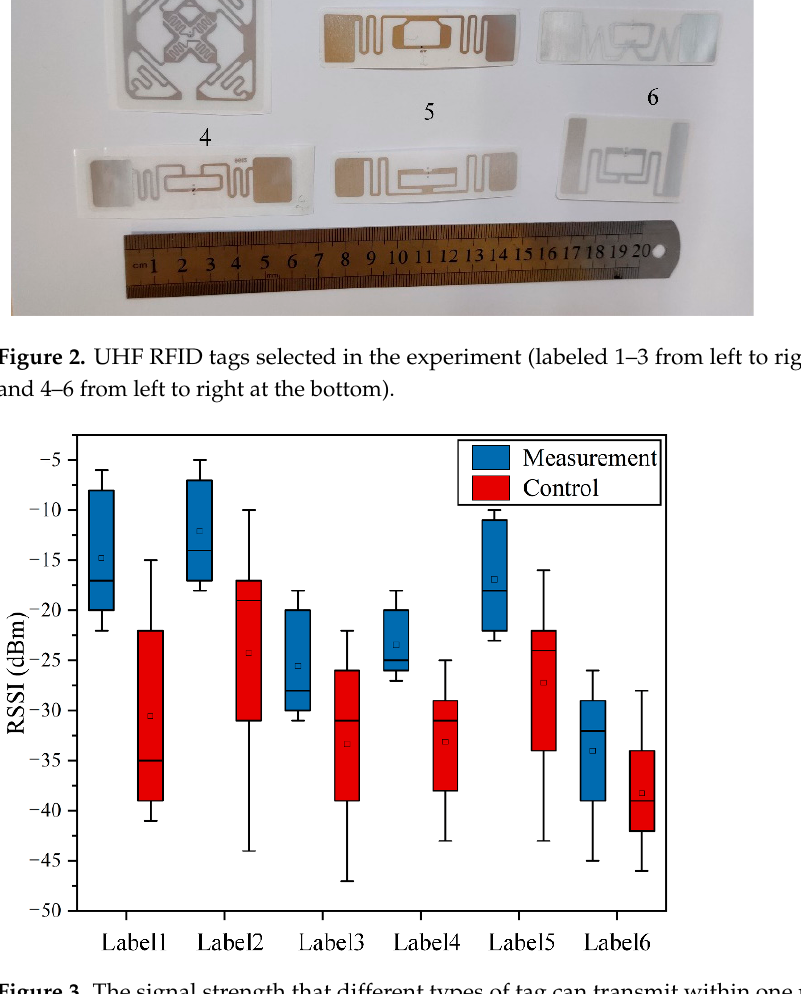
Figure 3. The signal strength that different types of tag can transmit within one meter (tested on a boxwood sample with 17% MC).